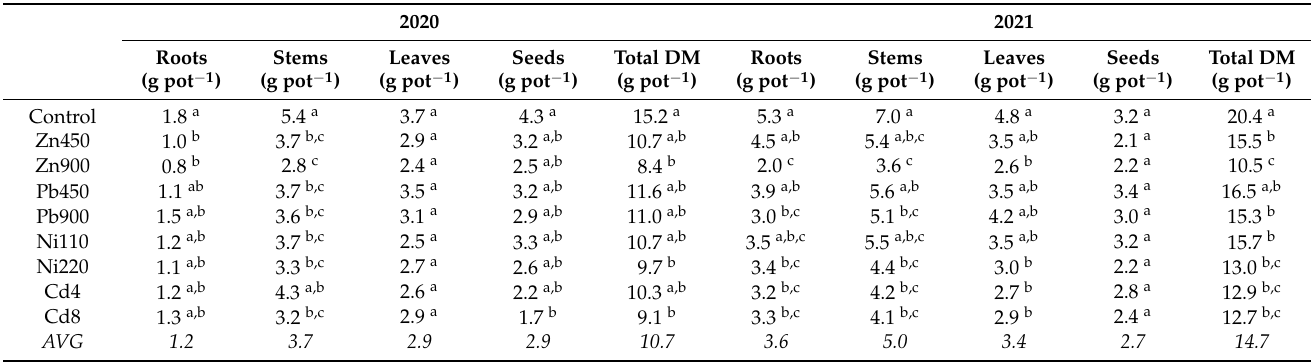
Table 4. Total biomass yield and plant fractions (roots, stems, leaves, and seeds) in the two years and in relation to HM treatments. Within the same column, values with different letters indicate statistical significance (according to HSD at р ≤ 0.05).